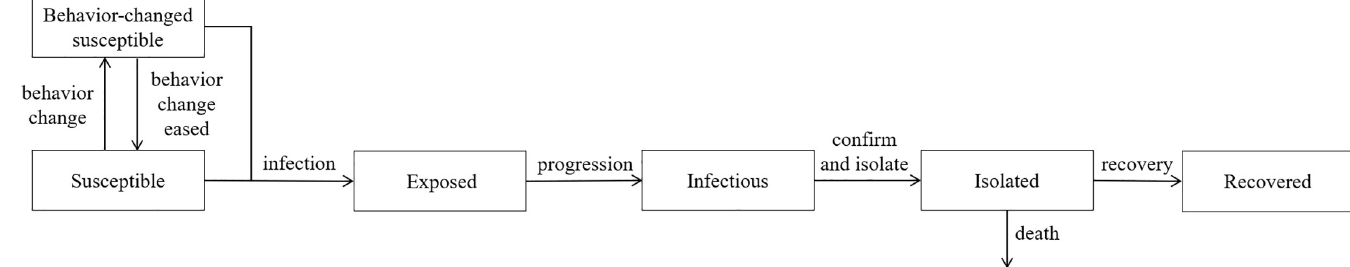
Fig 1. Flow diagram of COVID-19 transmission